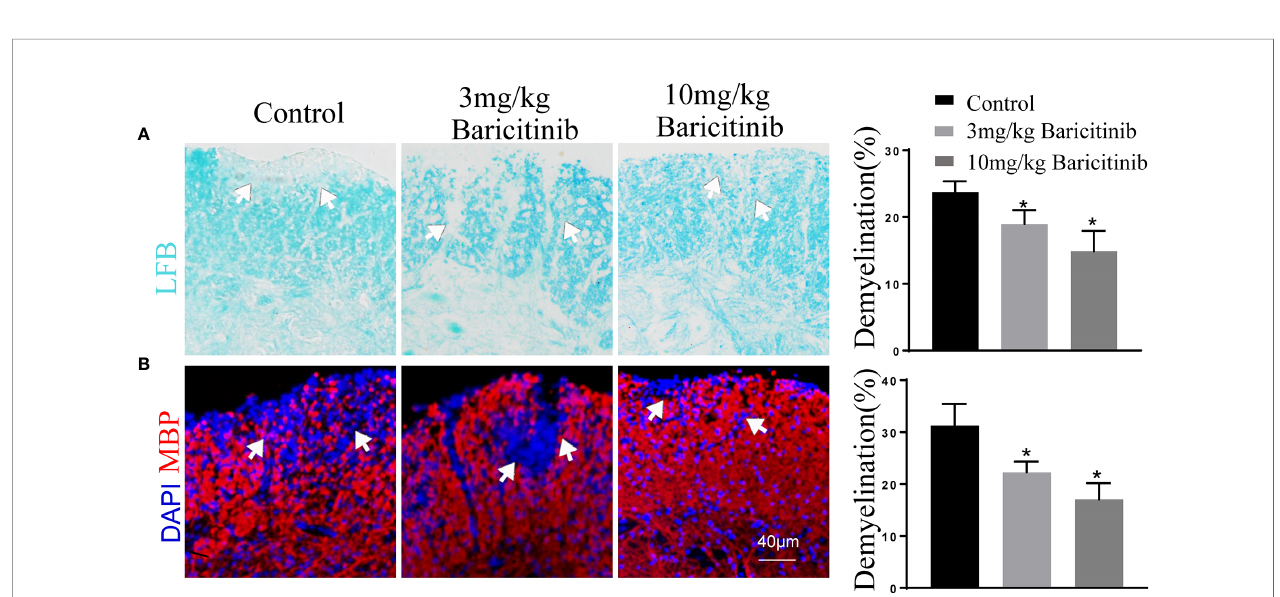
FIGURE 2 | Baricitinib reduces pathological tissue injuries in experimental autoimmune encephalomyelitis (EAE) mice. The extent of demyelination was semi- quantitatively analyzed. The results from each group are displayed as representative images, and the statistics of in fi ltration and demyelination are shown. Demyelination of the central nervous system (CNS) was evaluated by Luxol Fast Blue (LFB) (A) and myelin basic protein (MBP) (B) . Cell nuclei were counterstained with DAPI (blue). Demyelination of the CNS was remarkedly reduced in the baricitinib-treated groups compared to that in the control group. The mean percentage of the microscopic fi elds with the lumbar spinal cord. Quantitative data are the mean ± SEM. *p < 0.05; n = 6 per group. SEM, standard error of the